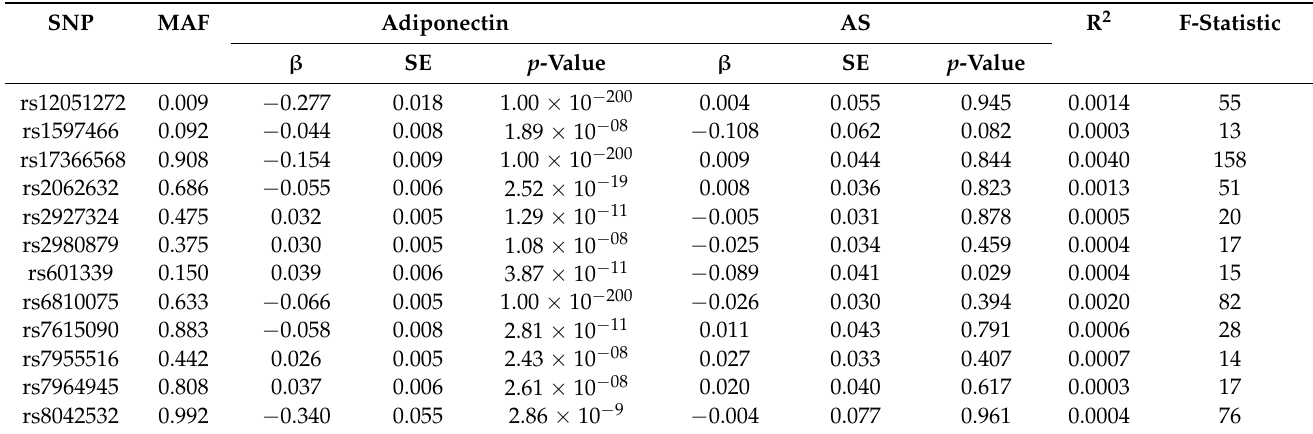
Table 1. Detailed statistics of selected instrumental variables for circulating adiponectin levels and their relationships with AS.